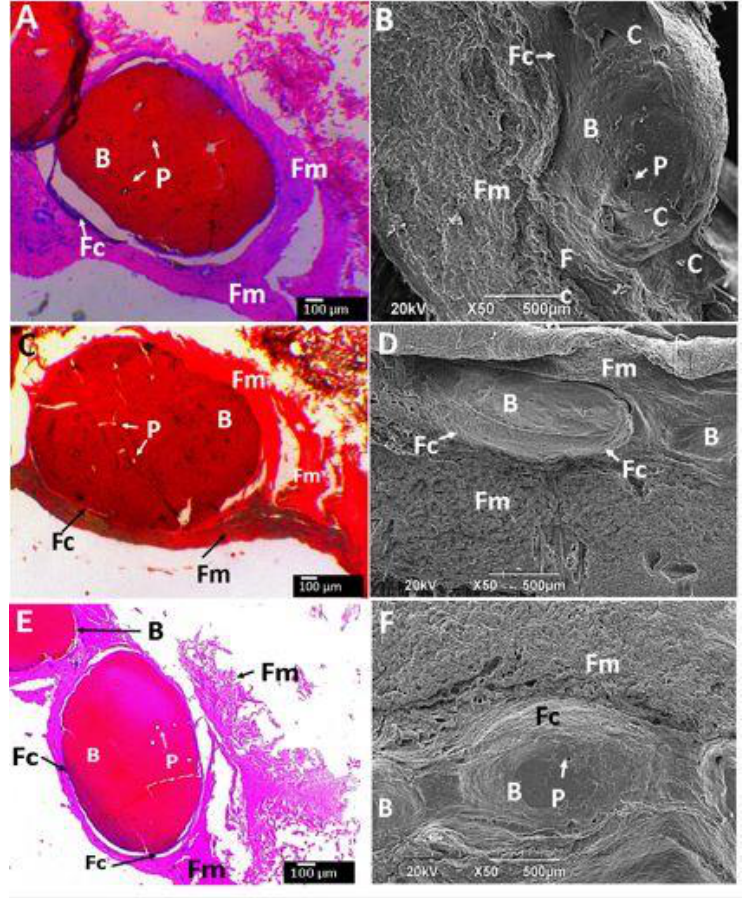
Figure 9. Beads implanted in subdermal tissue. ( A , B ): CS-GO-TiO 2 -GLA. ( C , D ): CS-TiO 2 -GLA. ( E , F ): CS-TiO 2 -GLA. ( A , C , E ): Hematoxylin and eosin stain technique at 4 × . ( B , D , F ): SEM technique. B: Bead. P: Pore. Fc: Fibrous capsule. Fm: Fibrous membrane. C: Cell.